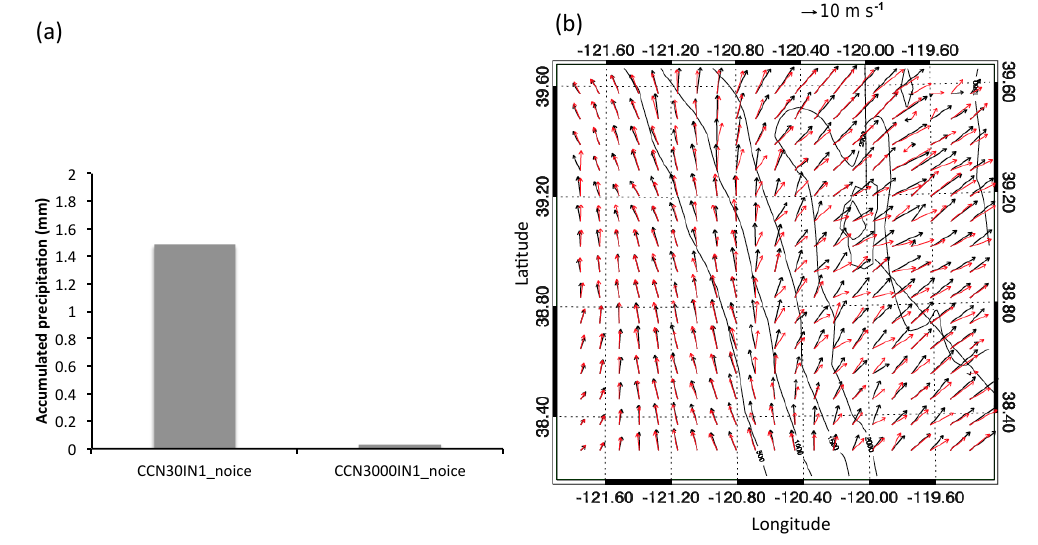
Figure 11. Results for the two simulations without ice-related microphysics, i.e., CCN30IN1_noice and CCN3000IN1_noice, which are based on CCN30IN1 and CCN3000IN1, respectively, for the WMOC: (a) the domain-averaged accumulated precipitation and (b) the spa- tial distribution of wind field at about 1.7km above the ground at 14:00UTC. Red in (b) denotes CCN3000IN1_noice and black denotes